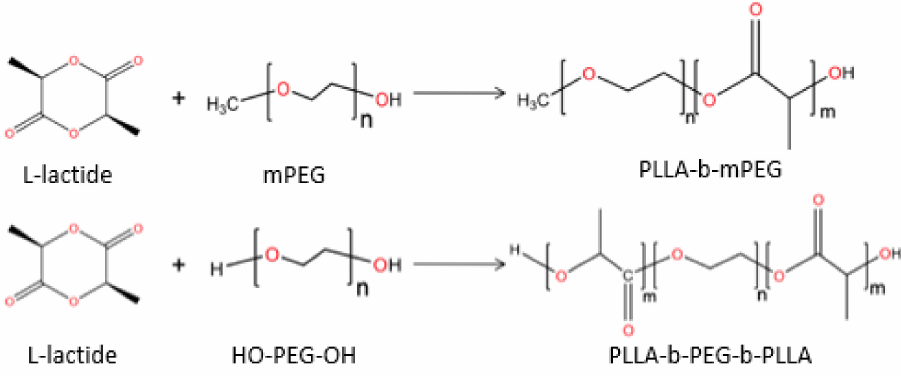
Figure 14. Synthesis of PPLA/PEG star-shaped copolymers by ring opening